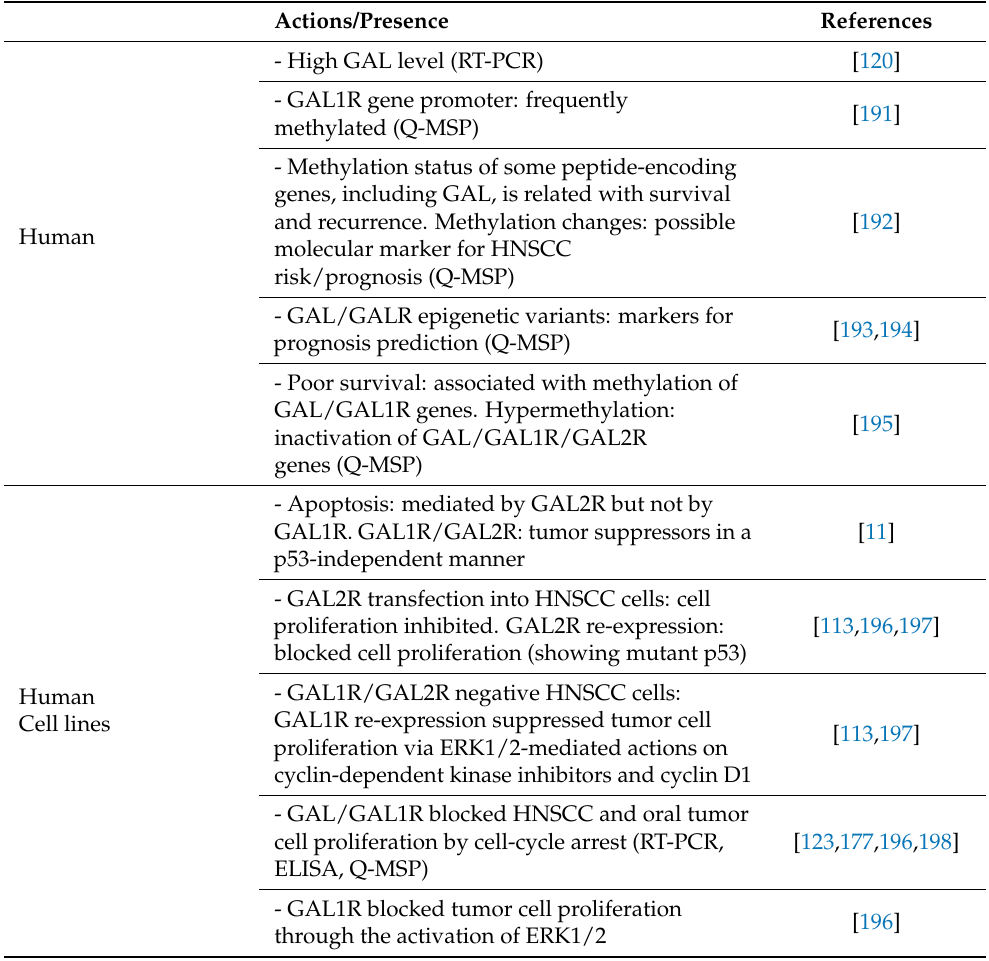
Table 3. Involvement of the galaninergic system in head and neck squamous cell